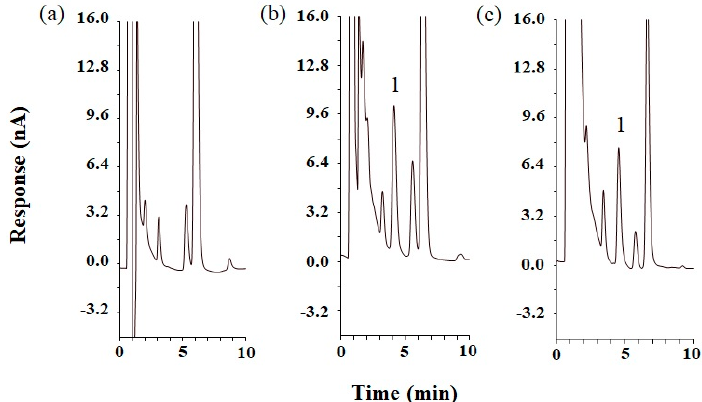
Figure 3. High performance liquid chromatograms of: ( a ) blank rat plasma; ( b ) standard resveratrol (RES) (1000 ng/mL) spiked with blank rat plasma; and ( c ) rat plasma sample at 30 min after oral administration of 50 mg/kg RES self-nanoemulsifying drug delivery system. Peak identification: (1) RES.